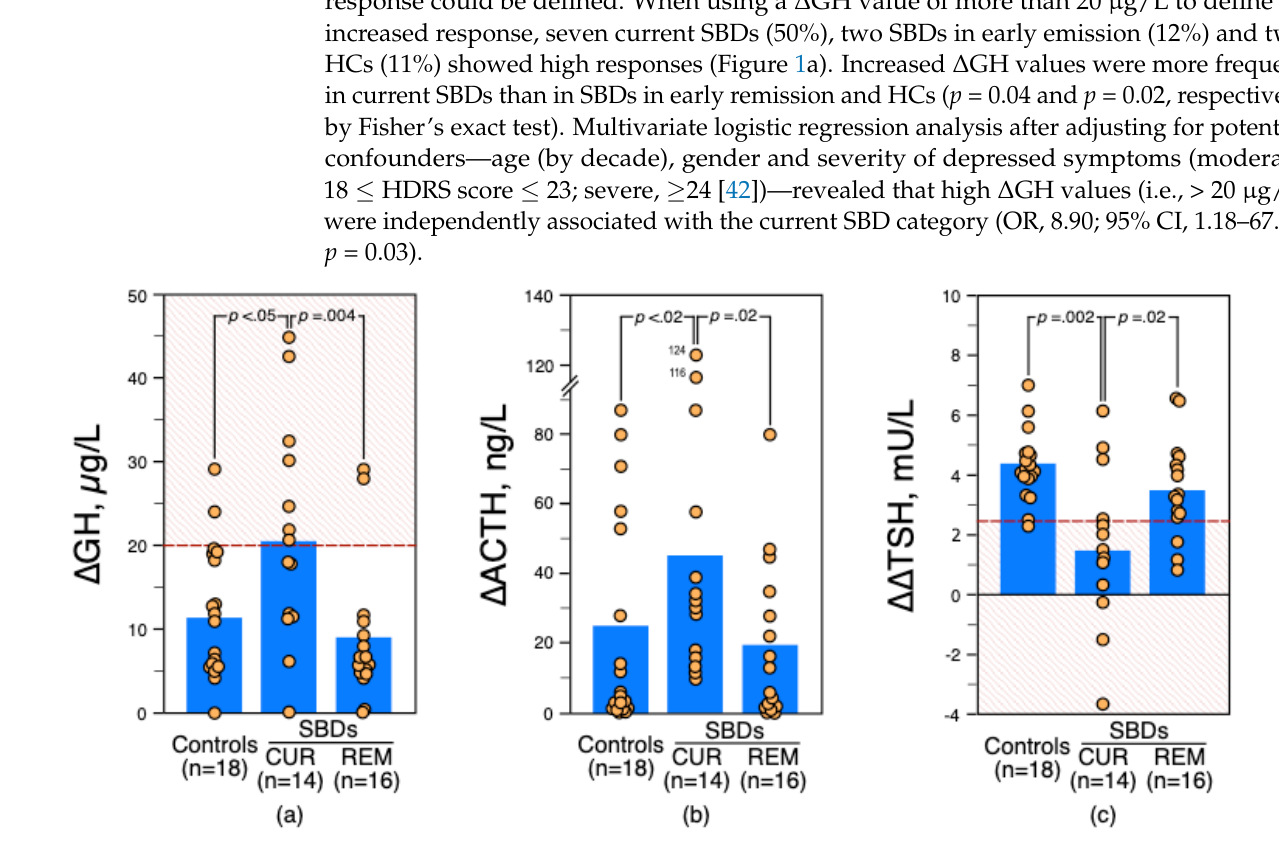
Figure 1. ( a ) Growth hormone ( ∆ GH) and ( b ) adrenocorticotropic hormone ( ∆ ACTH) responses to apomorphine (0.75 mg SC). ( c ) Difference between 11 PM and 8 AM maximum increments in thyrotropin ( ∆∆ TSH) after 200 µg of protirelin given intravenously to healthy controls and depressed patients with current (CUR) or in early remission (REM) suicidal behavior disorder (SBD). Values are plotted individually; histograms represent the group mean. Comparisons were tested with a two-tailed U-test. The dashed lines indicate the threshold values that separate increased and normal ∆ GH values and reduced and normal ∆∆ TSH values (abnormal values are located in the shaded